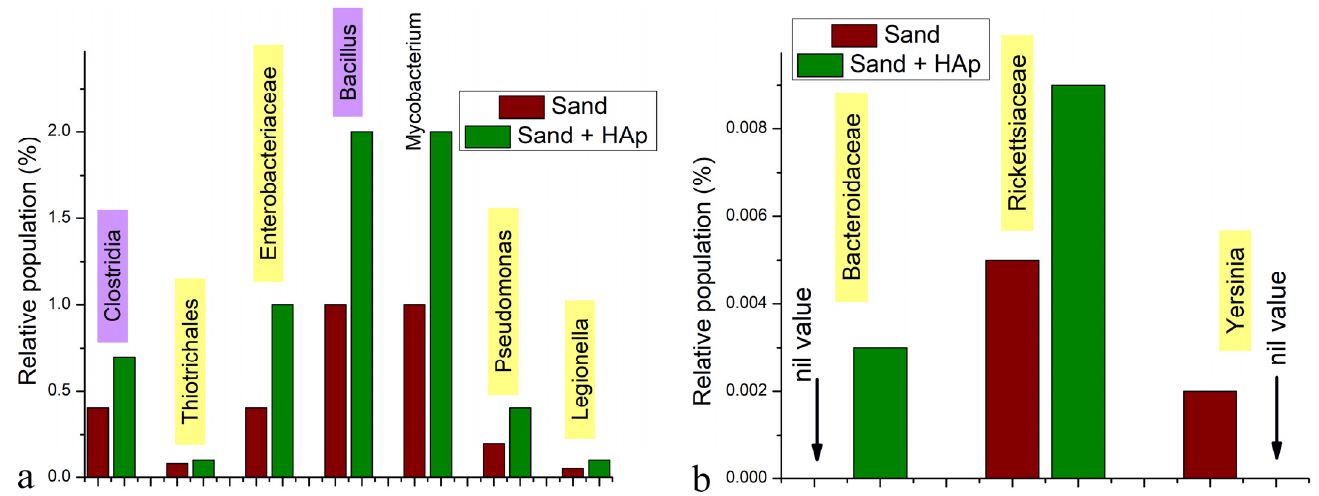
Figure 8. Relative presence of selected pathogenic bacterial taxa in the sandy soil microbiome present at concentrations higher ( a ) or lower ( b ) than 0.01% of the total microbiome before and after its treatment with HAp nanoparticles. Gram ‐ negative taxa are framed in yellow, while Gram ‐ positive taxa are framed in violet.